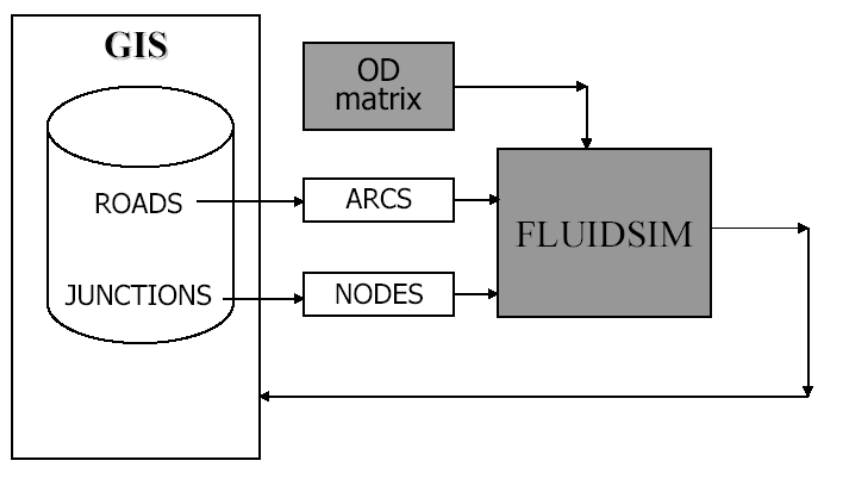
Figure 1. Architecture of the FLUIDSIM